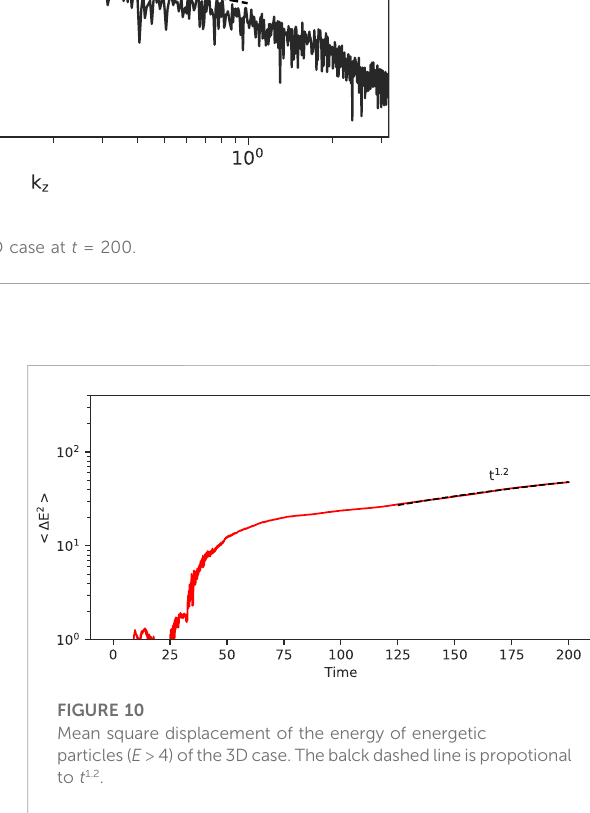
energies. The index of the observed super-diffusion in the 2D case (2.27) is higher than that in the 3D case (1.2). This also indicates that the 2D acceleration is more ef fi cient than the 3D acceleration. We interpret this because in the 2D case particles can be more easily trapped in the turbulence than in the 3D case.